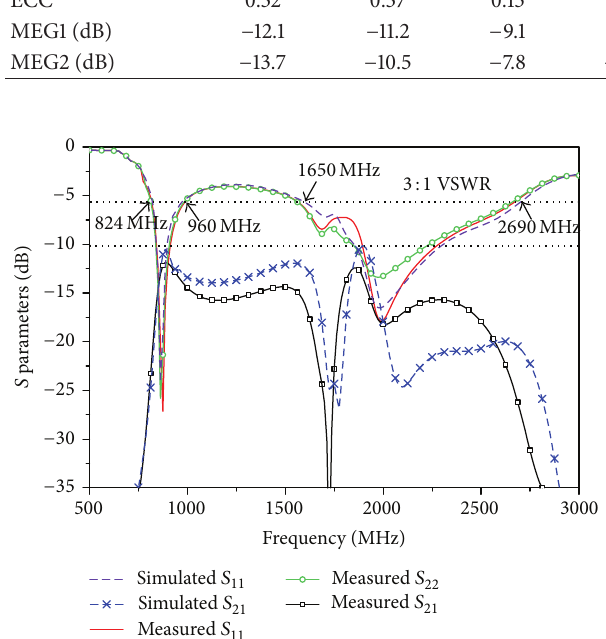
Figure 5: Simulated and measured 𝑆 parameters of the proposed antenna